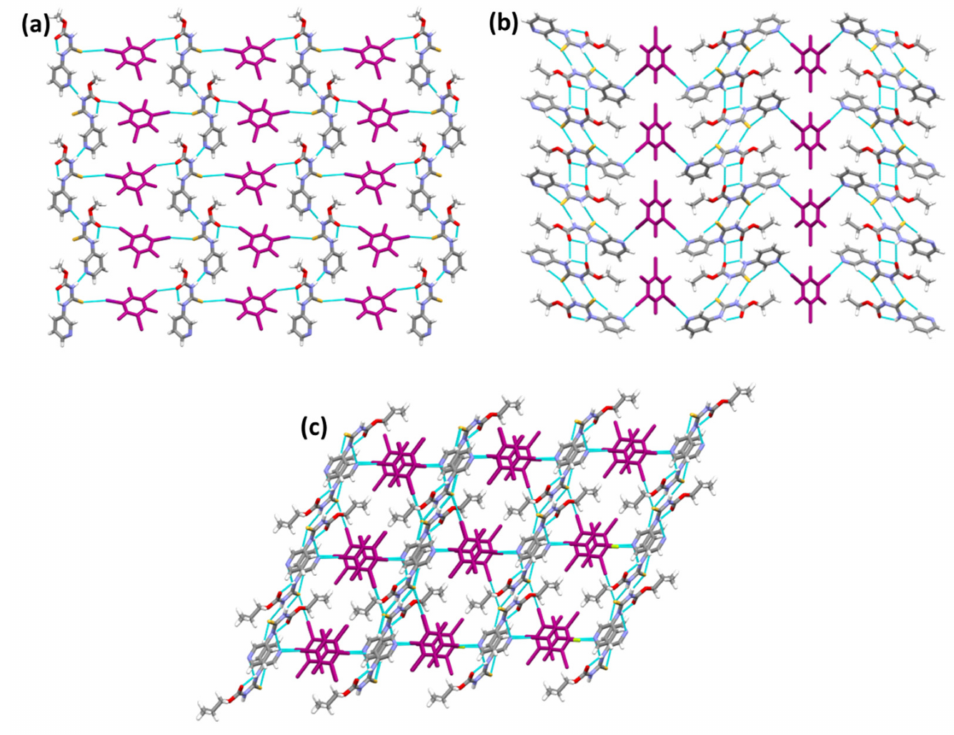
Figure 6. Crystal packing in the structures of ( a ) A1 · D1 , ( b ) (A2) 2 · D1 , and ( c ) A3 · D1 . The chloroform and D2 molecules in the lattice of (A1) 2 · D2 and A2 · D2, respectively (Figure 7a,b), are primarily space-filling molecules, and do not seem to engage in any strong interactions with neighboring molecules. Despite (A1) 2 · D2 being a solvate and A2 · D2 being a pure co-crystal, both structures adopt the same packing. Furthermore, (A1) 2 · D2 and A2 · D2 exhibit similar packing behavior to A1 · D1 and A3 · D1 , where target molecules form chains interconnected by the co-formers through halogen bonds. (A3) 2 · D2 is different from (A1) 2 · D2 and A2 · D2 in that (A3) 2 · D2 forms I · · · Npyr halogen bonds with D2 , while